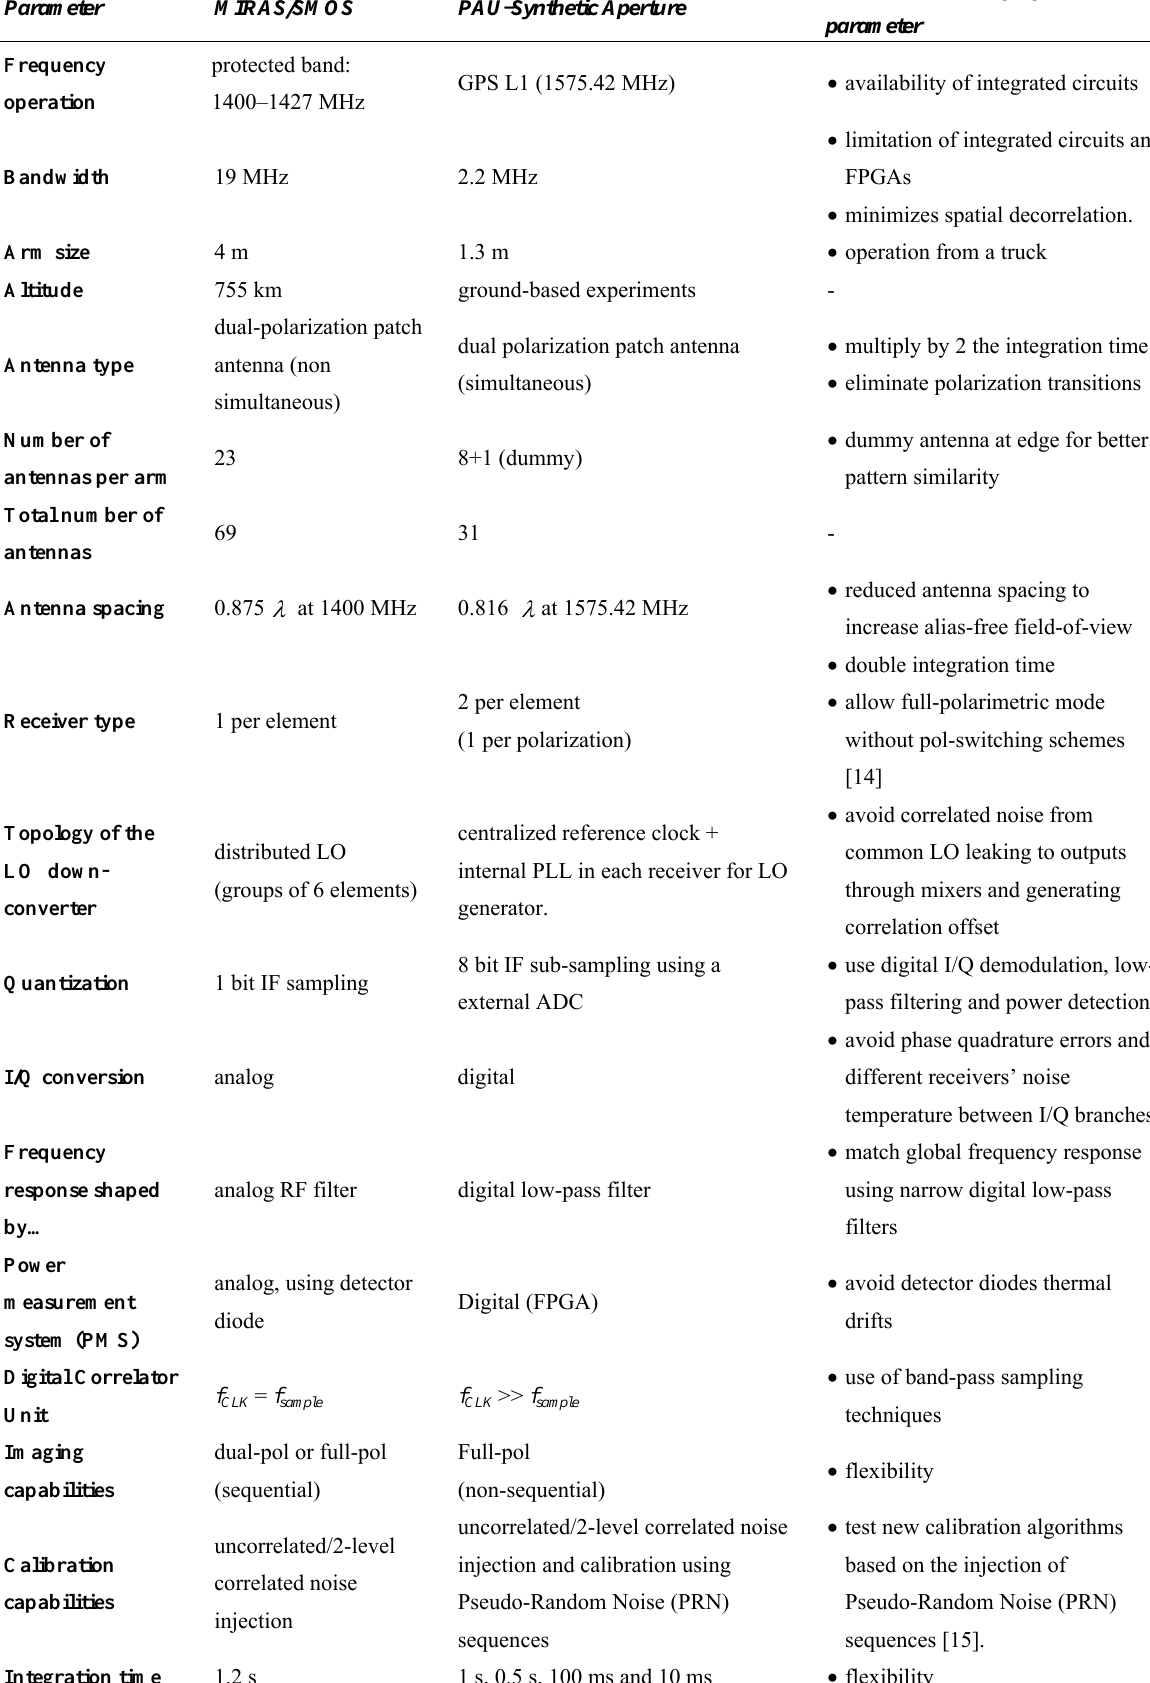
Table 1. MIRAS instrument and PAU - Synthetic Aperture main